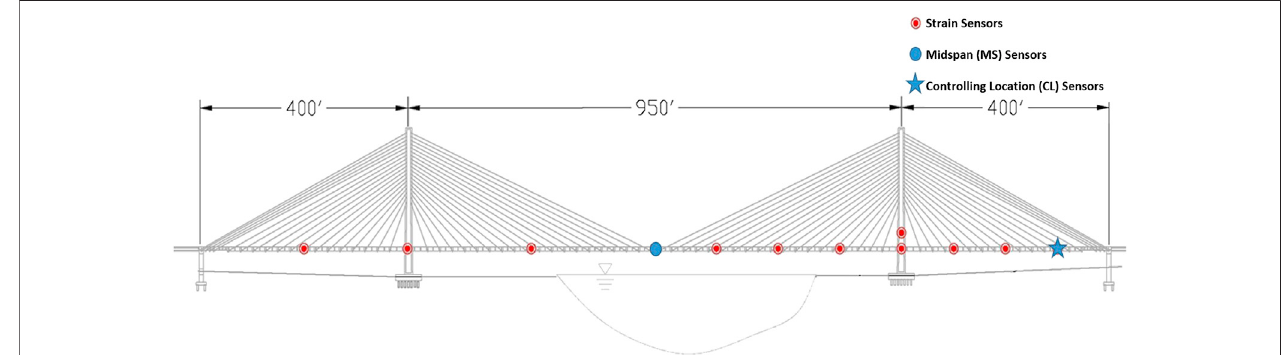
FIGURE 1 | Schematic elevation of IRIB, including the longitudinal position of the key